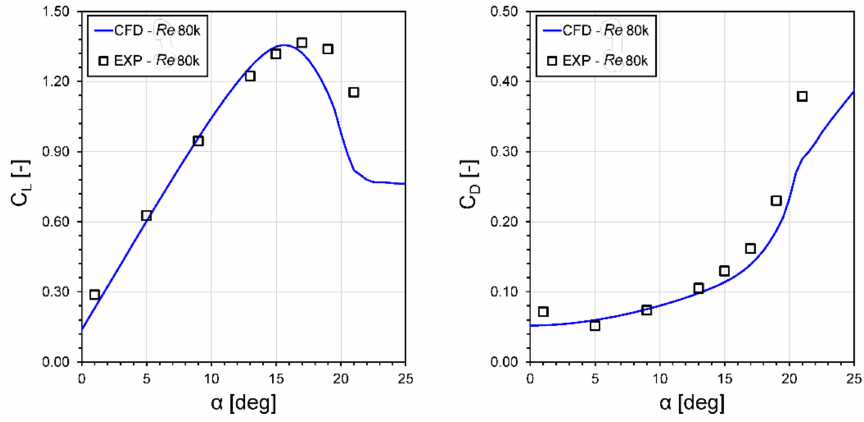
Figure 9. Comparison between CFD and experimental polars with a high turbulence flow.